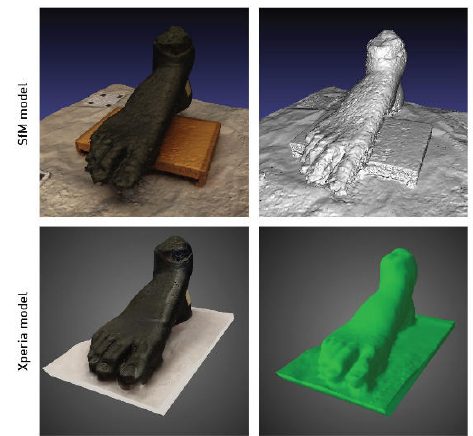
Figure 13. Bronze masculine foot SfM model in comparison to 3D Creator model